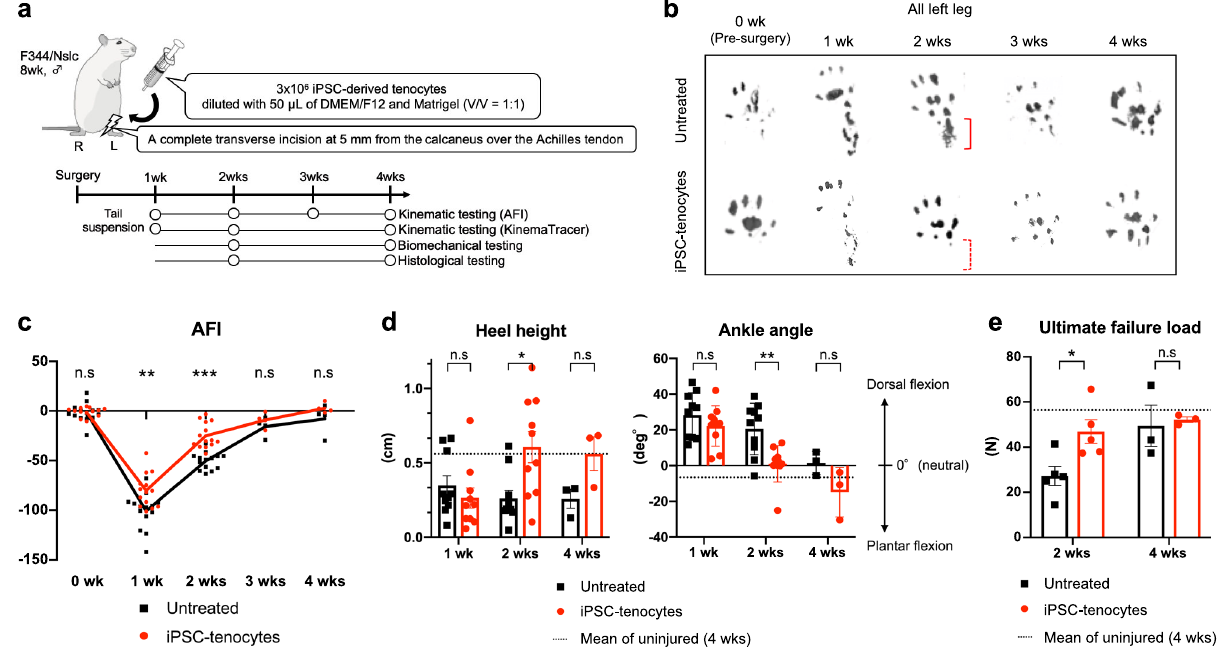
Fig. 4 Grafting of iPSC-tenocytes promotes the recovery of motor function after Achilles tendon rupture in rats. a Schematic representation of animal experimental setup. b Representative footprints of iPSC-tenocytes rats and untreated rats at weeks 0 (before surgery), 1, 2, 3, and 4 after transplantation. c , d Kinematic analyses of iPSC-tenocytes rats, untreated rats, and uninjured rats. AFI (Achilles functional index) was measured at weeks 0 (before surgery), 1, 2, 3, and 4 after transplantation. A value of 0 indicates normal function and a negative value indicates impairment (0, 1, 2 weeks: n = 14: biologically independent samples; 3 and 4 weeks: n = 4: biologically independent samples) ( c ). Heel height (cm) and ankle angle (°) of rats walking on a treadmill were assessed at weeks 1, 2, and 4 after transplantation. A positive angle indicates dorsal fl exion, a negative angle indicates plantar fl exion ( d ). Data represent mean ± SE (1 and 2 weeks: n = 10: biologically independent samples; 4 weeks, uninjured rats: n = 3: biologically independent samples). Dotted lines in the fi gures show the mean score for uninjured rats. e Biomechanical analysis of iPSC-tenocytes rats, untreated rats, and uninjured rats. Ultimate failure load (N) of regenerated tendons harvested from rats was assessed at weeks 2 and 4 after transplantation. The dotted line in the fi gure shows the mean score for uninjured rats. Error bars: mean ± SE (2 weeks: n = 5: biologically independent samples; 4 weeks: n = 3: biologically independent samples; uninjured rats: n = 7: biologically independent samples). * P < 0.05; ** P < 0.01; *** P < 0.001 by two-tailed Welch ’ s t-test ( c , d , e ). n.s., not signi fi cant; untreated, incised but not transplanted; uninjured, neither incised nor transplanted. Source data are provided as a Source Data fi